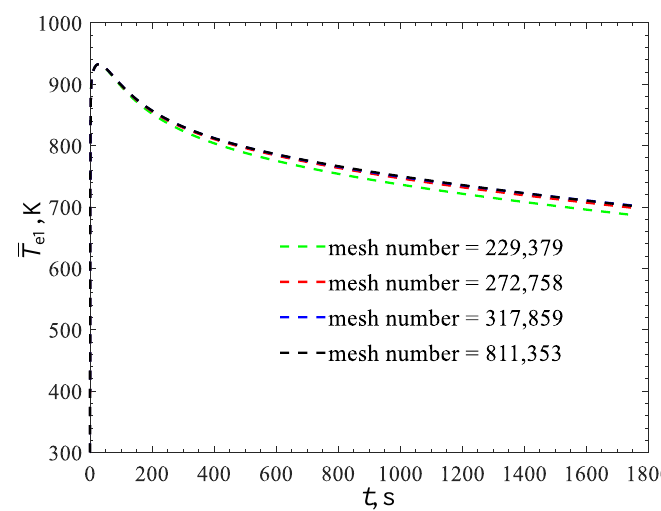
Figure 2. The curve of mesh independence verification.